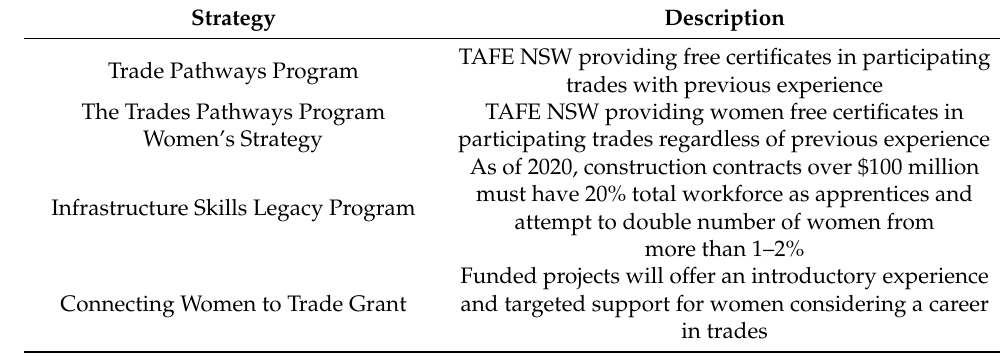
Table 1. NSW Government recent strategies for improvements for women in construction [15].